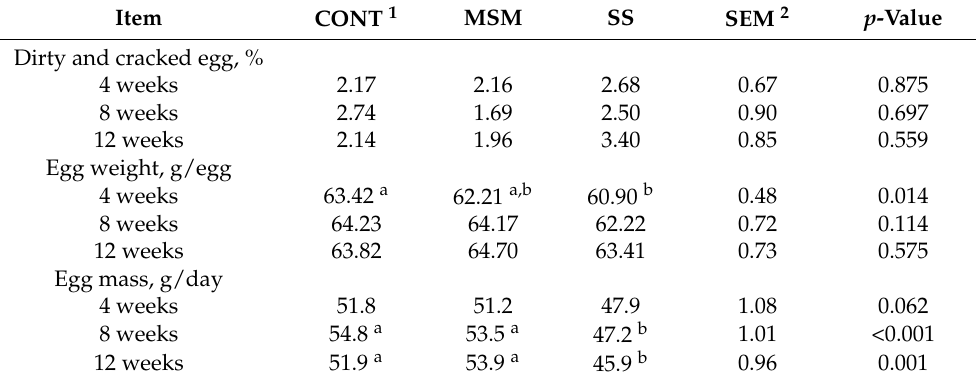
Table 3. Effects of dietary sulfur on dirty and cracked eggs, egg weight, and egg mass in laying hens ( n = 8). Item